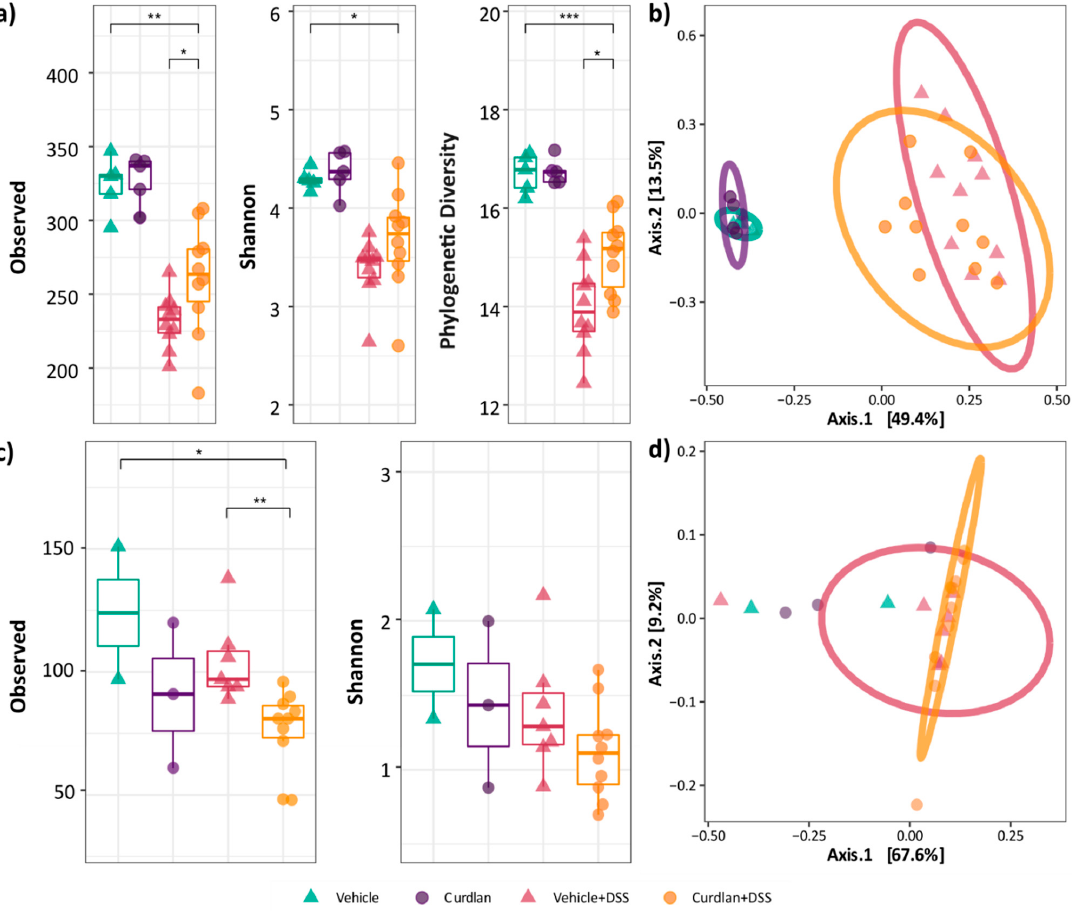
Figure 3. Effect of curdlan and DSS on the microbiome and mycobiome alpha and beta diversity. ( a ) For 16S sequencing, alpha diversity is measured by observed, Shannon and phylogenetic diversity matrices. ( b ) Beta diversity plots for 16S. ( c ) For ITS1 sequencing, alpha diversity is measured with observed and Shannon indices. ( d ) Beta diversity for ITS1 sequencing. Individual samples are represented as symbols. The observed species are plotted for vehicle (green), curdlan (purple), vehicle+DSS (pink) and curdlan+DSS (orange). Statistical differences were tested through Wilcoxon methods, where p -value of <0.05 was considered to be significant. * p -value < 0.05; ** p -value < 0.01; *** p -value < 0.001.